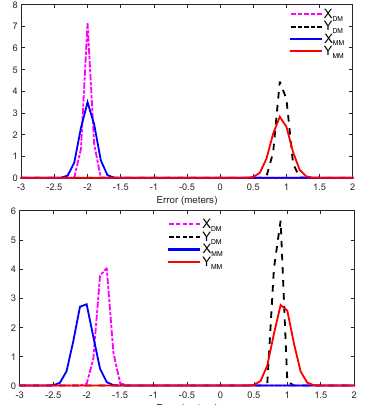
Figure 18. Overlap of PDFs of X and Y coordinates, estimated by the developed method (DM) and manually measured (MM), tile 4 (top) and tile 8